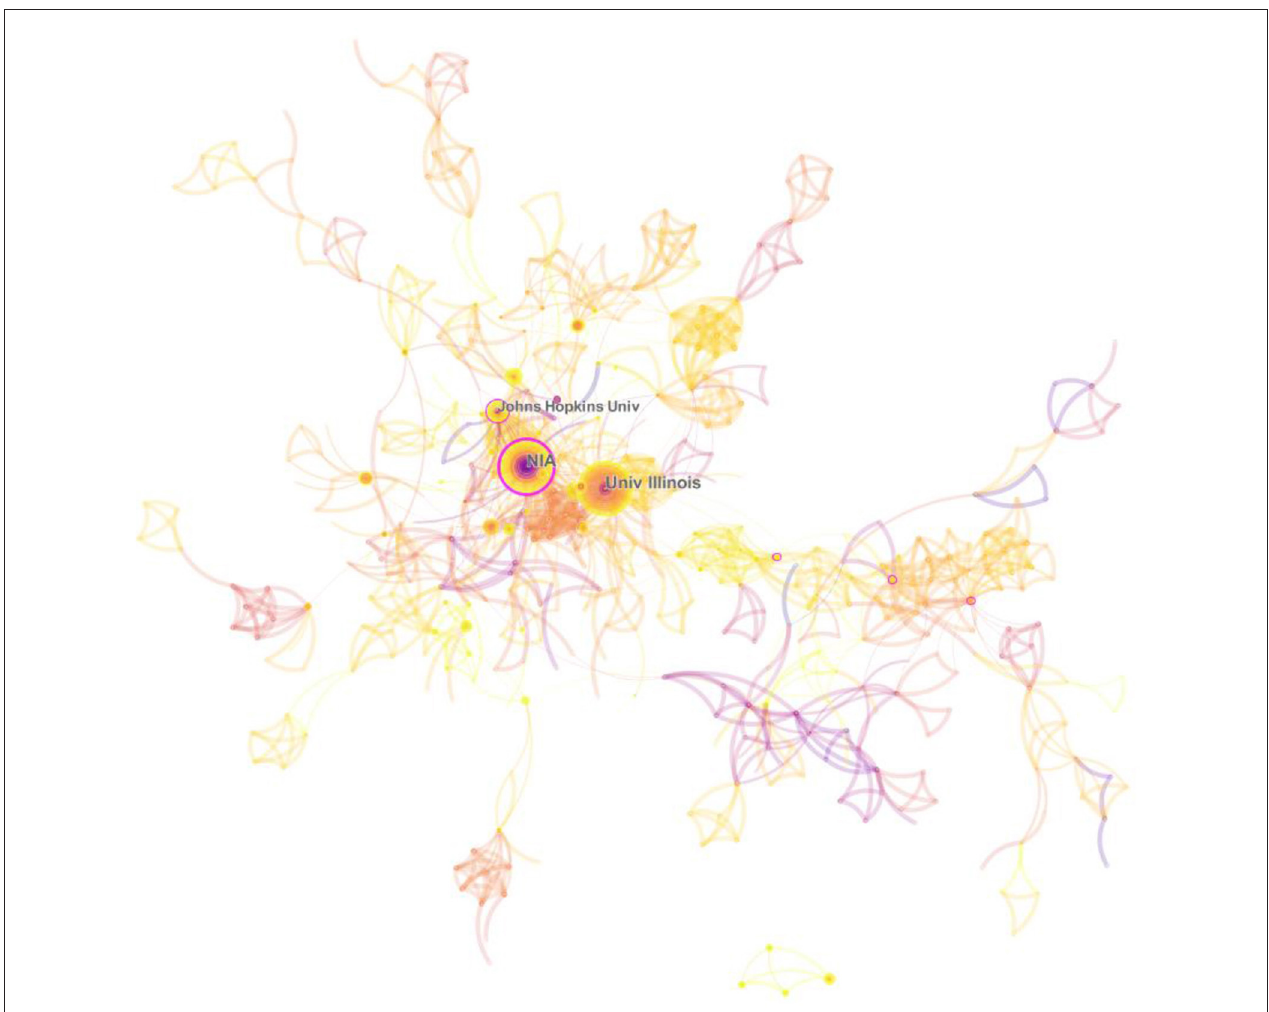
FIGURE 4 | Knowledge map of co-institution collaboration